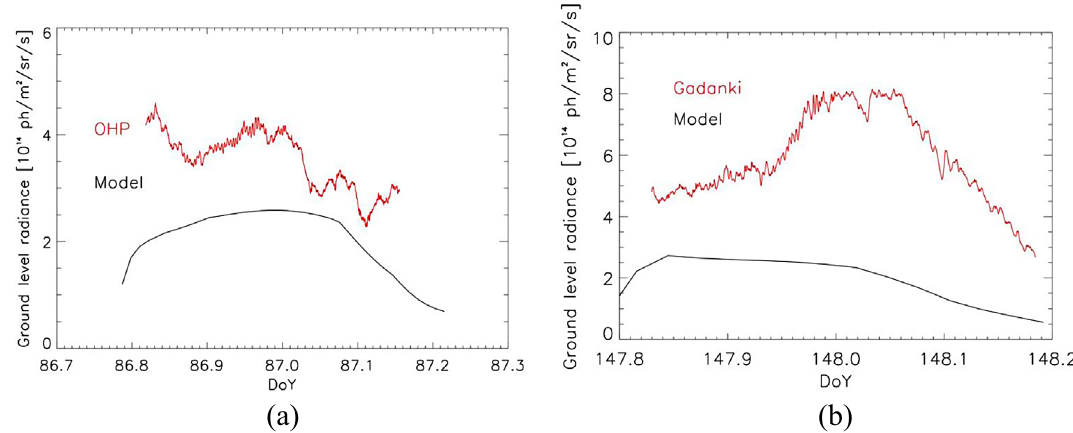
Fig. 7. (a) Comparisons between the measurement campaign at OHP, France in red and the model in black. (b) Same but for Gadanki, India. The model underestimates in both cases the intensity of the nightglow measured on the ground level, especially at Gadanki, where the night showed a strong activity of gravity waves.